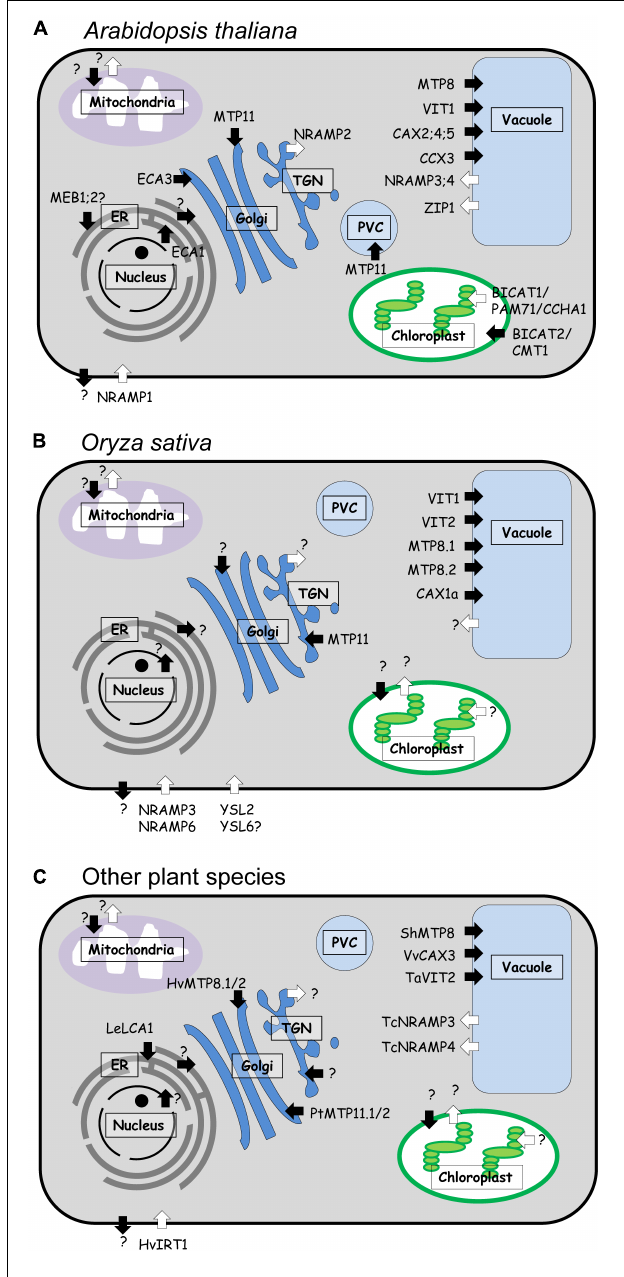
FIGURE 3 | Subcellular localization of Mn transport proteins in aerial parts of different plant species. (A) Arabidopsis, (B) rice, and (C) other species. White arrows represent import into the cytosol, black arrows represent export from the cytosol. Transport pathways with uncharacterized Mn transporters are indicated by a question mark. Hv, Hordeum vulgare ; Le, Lycopersicum esculentum (syn. Solanum lycopersicum ); Pt, Populus trichocarpa ; Sh, Stylosanthes hamata ; Ta, Triticum aestivum ; Vv, Vitis vinifera